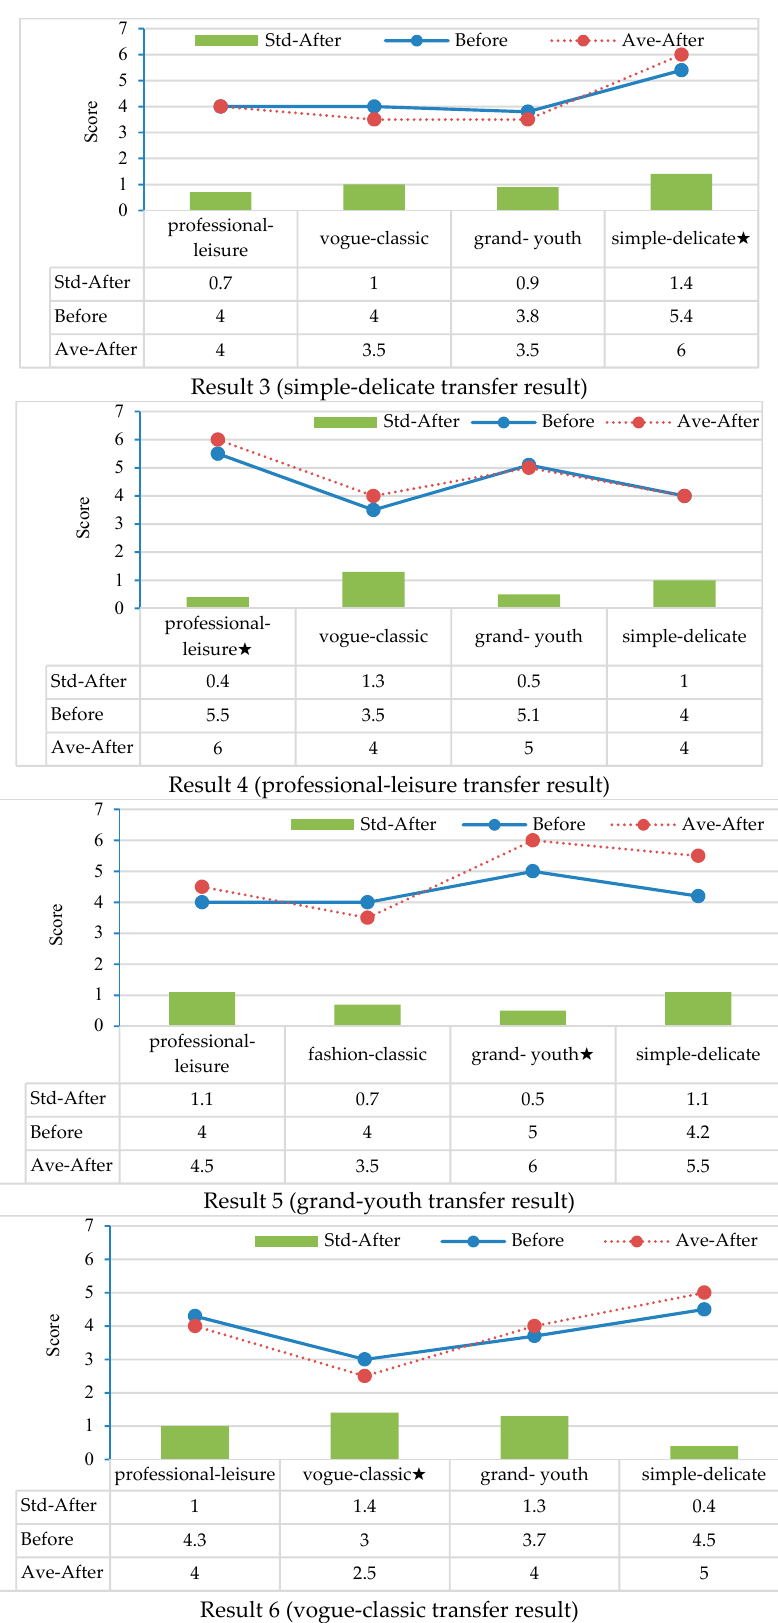
Figure 10. New product evaluation results. We compared the new coat’s style scores from the BP model and questionnaires. The ”Before” scores were obtained by inputting the parameters of the coat into the trained BP neural network model. The “Std-After” and “Ave-After” scores were obtained through questionnaires, the former is the standard deviation and the latter is the average.